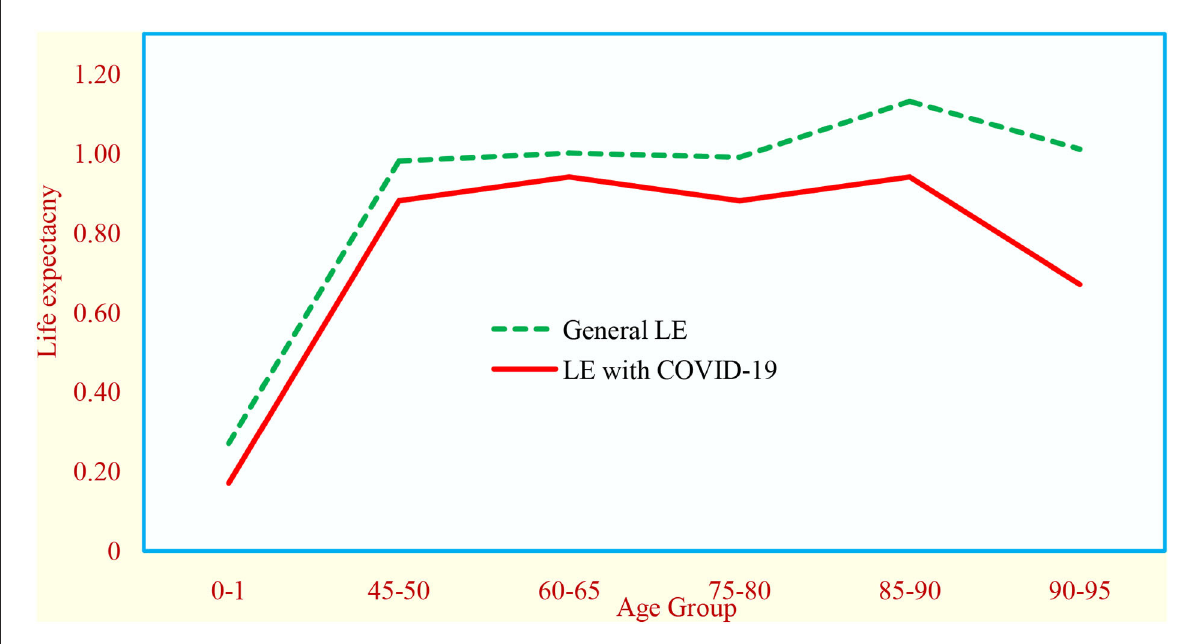
FIGURE2 Effect of COVID − 19 on life expectancy at birth in India (June 2020